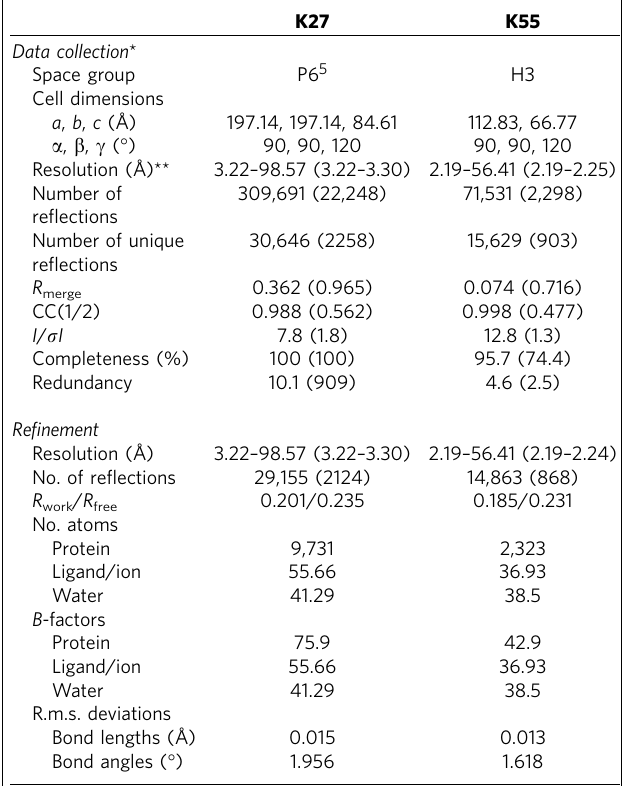
Figure 1 | Bio-layer interferometry of DARPins K27 and K55 binding to K-Ras wild type loaded with GDP or GTP c S. Bio-layer interferometry was used to investigate DARPin binding to biotinylated K-Ras wild type loaded with different nucleotides, immobilized on a streptavidin biosensor. The vertical dotted line indicates the transition from association to dissociation phases. Calculated K d values for each experiment are shown. Replicates are not included in this data but the experiment was repeated twice with similar results. Table 2 | Data collection and refinement